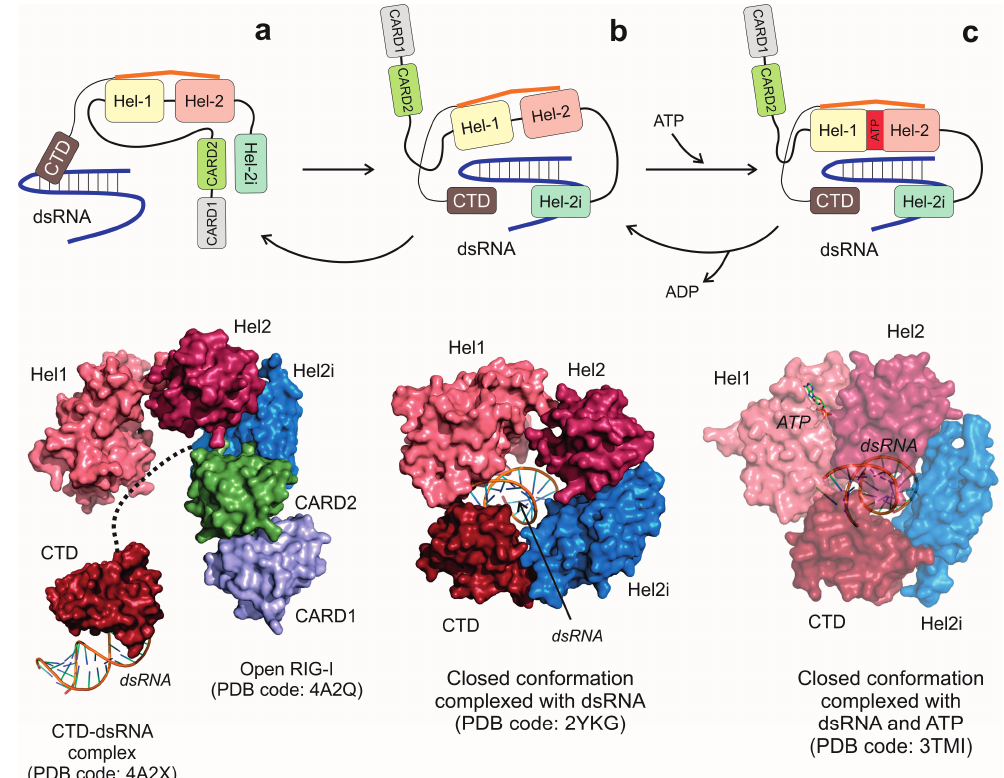
Figure 5. Structural interpretation of the mechanism of RIG-I activation by dsRNA. ( a ) In an initial step, the protein is in an open conformation and the exogenous viral